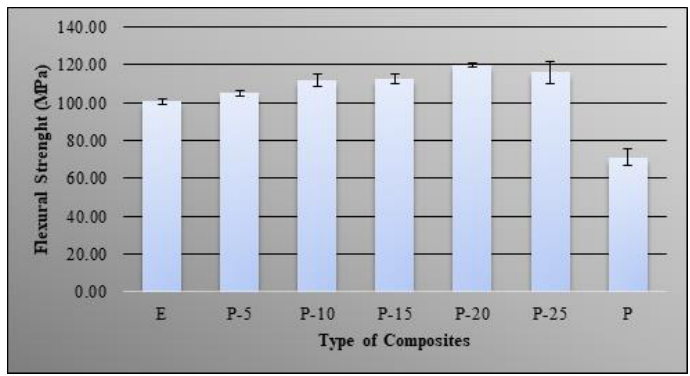
Figure 5. Flexural strength of bio-phenolic/epoxy blends, neat epoxy, and bio-phenolic material.